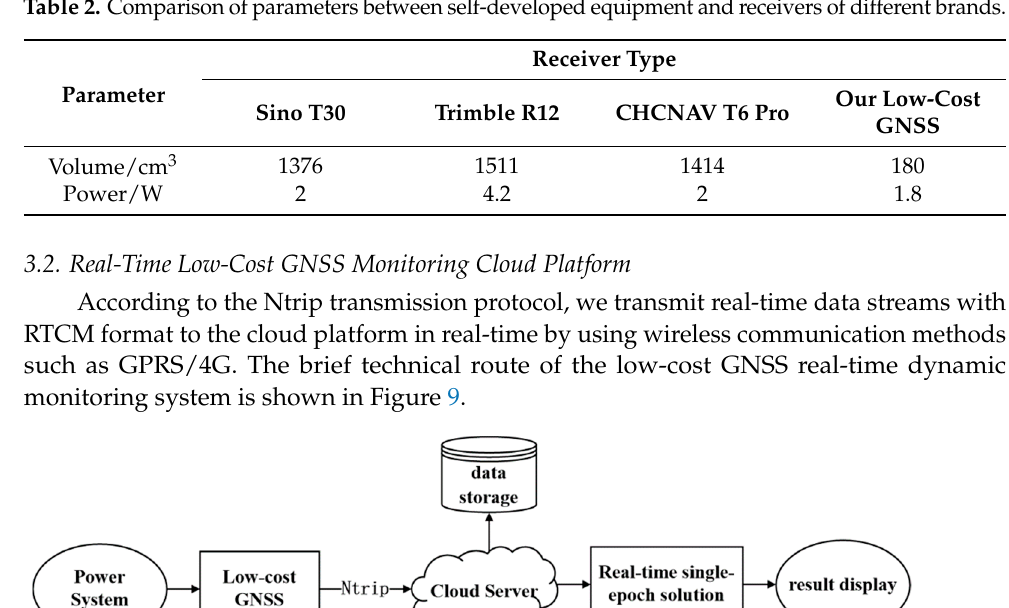
Table 2. Comparison of parameters between self-developed equipment and receivers of different brands.